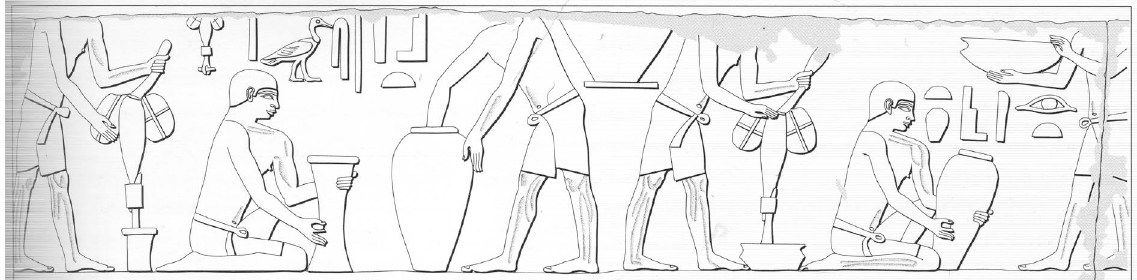
Figure 7. The making of stone vessels as depicted in an Old Kingdom relief from an unknown tomb at Saqqara. Egyptian Museum, Cairo JE 39866. Drawing by P. Der Manuelian after Maspero 1915, pp. 25-27, pl. 22; published in Arnold & Pischikova 1999: fig. 73; courtesy P. Der Manuelian.